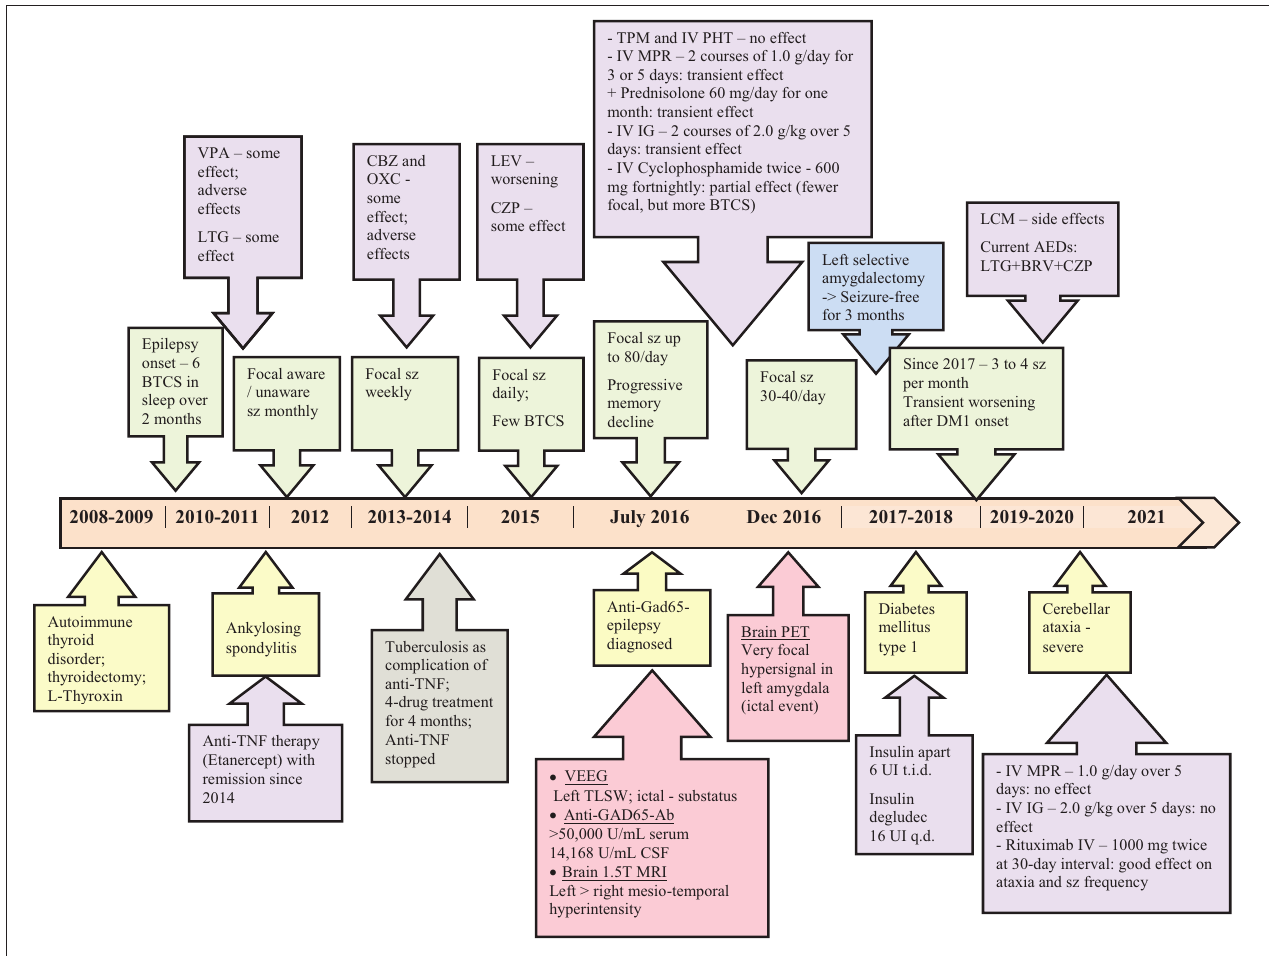
FIGURE 4 | Timeline with diseases’ onset and course, the diagnostic work-up, relevant results and therapeutic